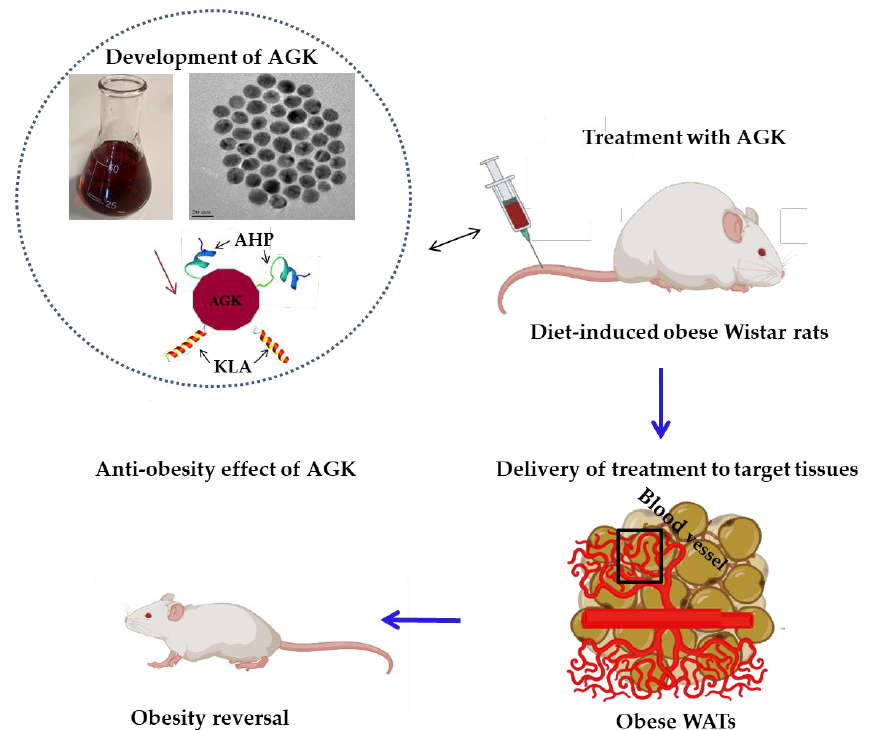
Figure 3. Anti-obesity mechanism of PHB-targeted AuNPs in obese rats. AGK targets and induce endothelial cell death in the WATs, resulting in body weight loss.